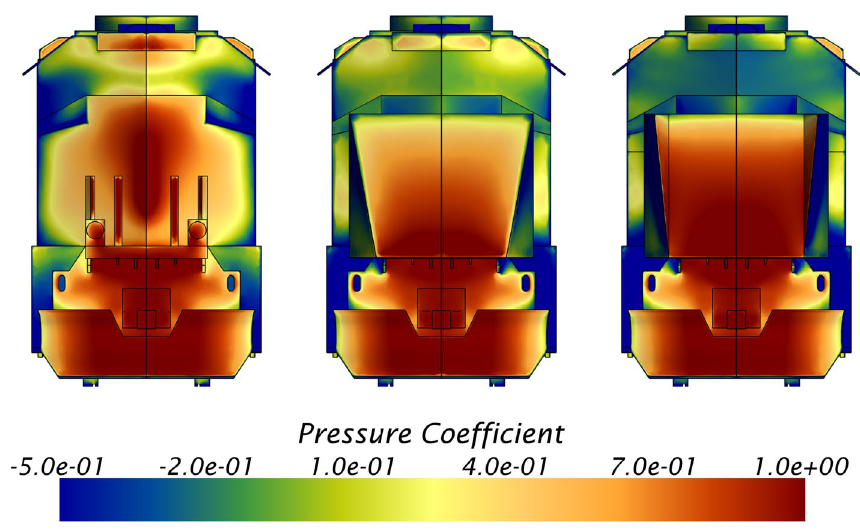
Fig. 9 Front-view surface plots of the static pressure coefficient, C P , on the baseline locomotive without an add-on nose fairing (left), with the best performing primary fairing (middle), and with the best performing secondary fairing